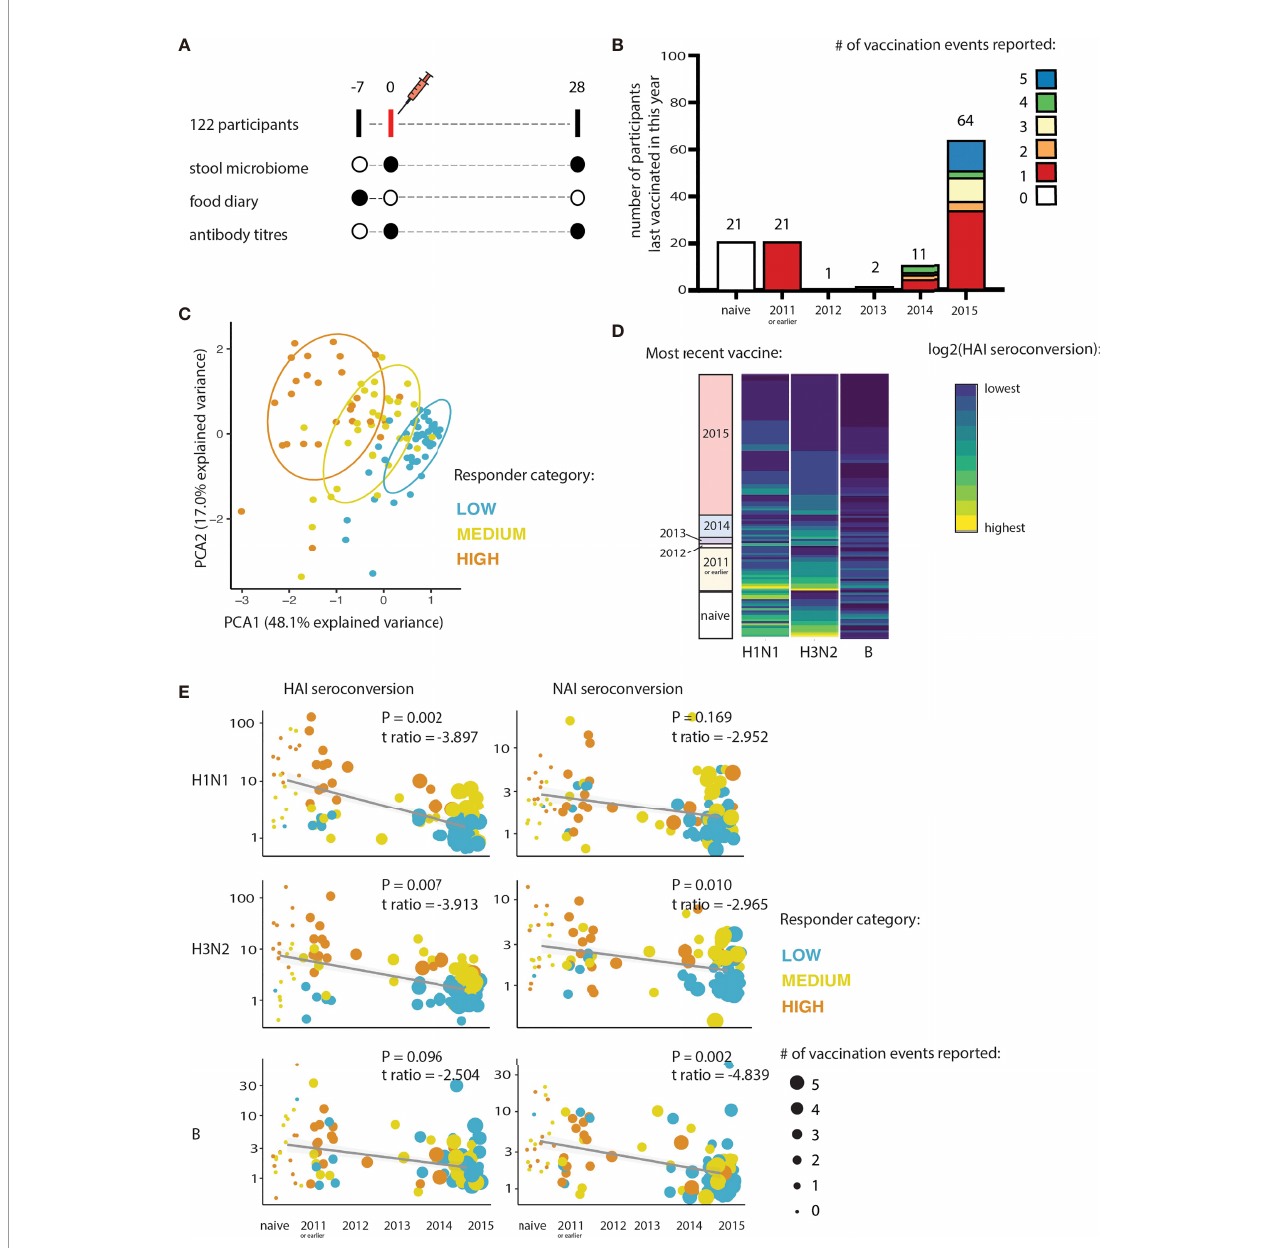
FIGURE 1 | In fl uenza vaccine responses are determined by vaccination history. (A) Schematic overview of sampling timepoints relative to the vaccination event. (B) Histogram summarizes the number of seasonal-in fl uenza vaccines received self-reported by participants at least 4 years prior to the study (2012-2015 inclusive; or from 2011-2015 inclusive). (C) Principal component analysis of both HAI and NAI seroconversion of each participant. Participants are coloured according to their responder category. (D) Heatmap showing relationship between seroconversion and year of most recent seasonal-in fl uenza vaccines received by participants in the 4 years prior to the study (2012-2015), and 2011 or earlier. Hemagglutinin (HAI) seroconversion to each of the in fl uenza subtypes contained in the vaccine is shown. (E) Relationship between seroconversion and vaccine history. Hemagglutinin (HAI) and Neuraminidase (NAI) seroconversions are shown, as is the response to each of the in fl uenza subtypes contained in the